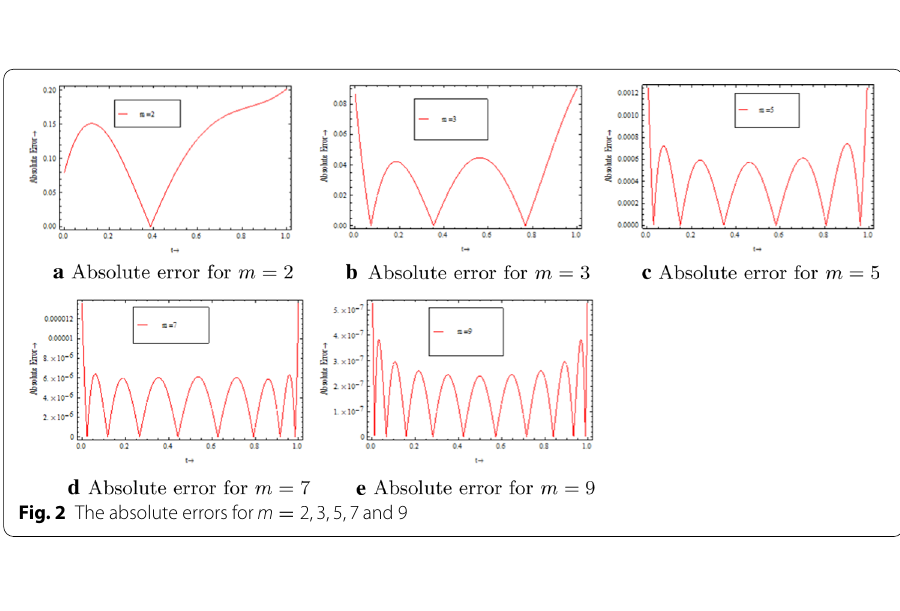
Fig. 2 The absolute errors for m = 2,3,5,7 and